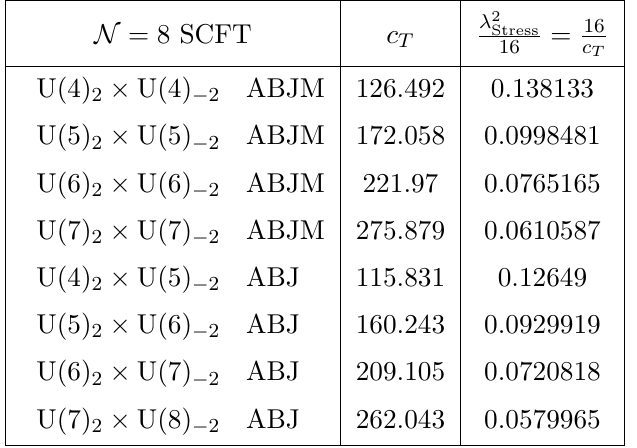
/ 16 for k = 2 ABJM or ABJ theories, as computed from Stress